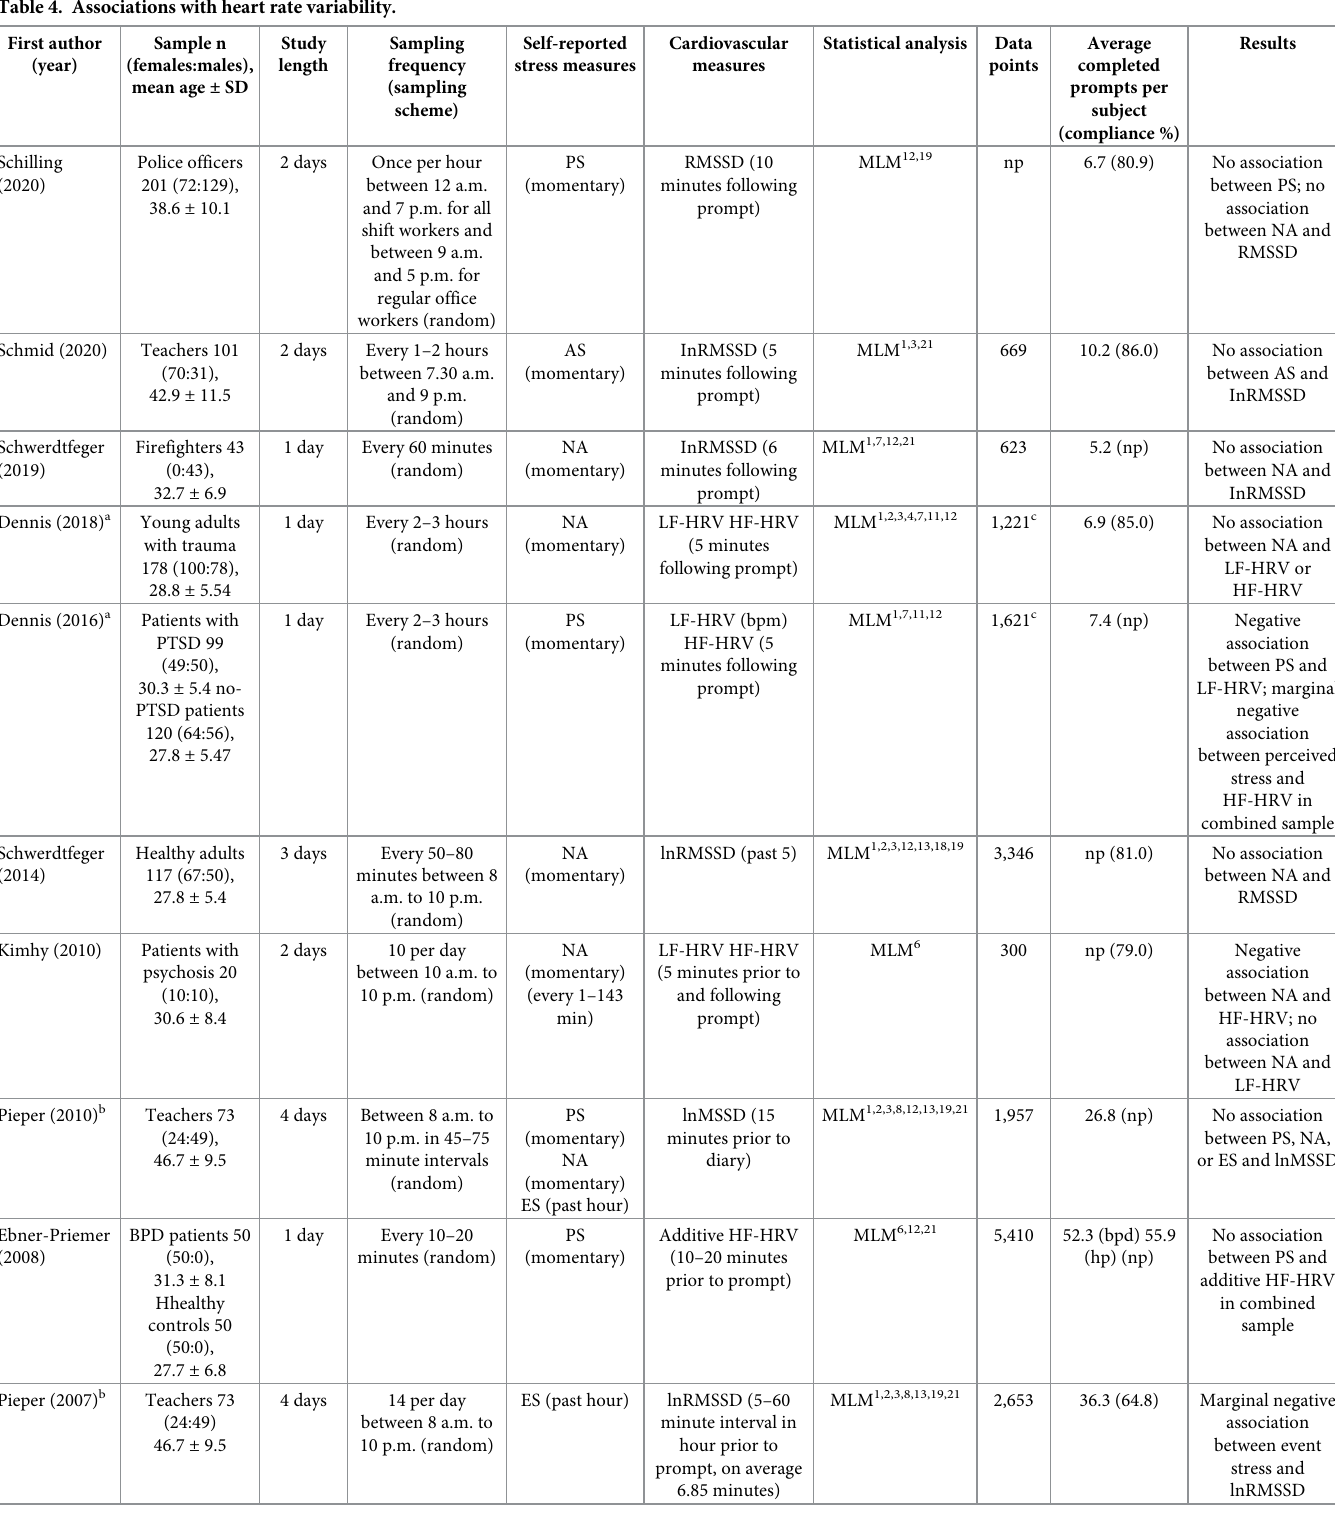
Table 4. Associations with heart rate